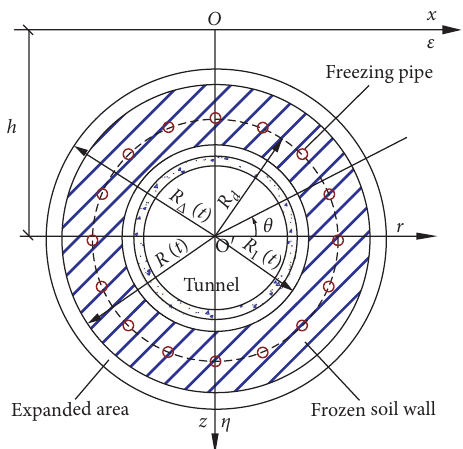
Figure 5: Coordinate system transformation after frozen wall